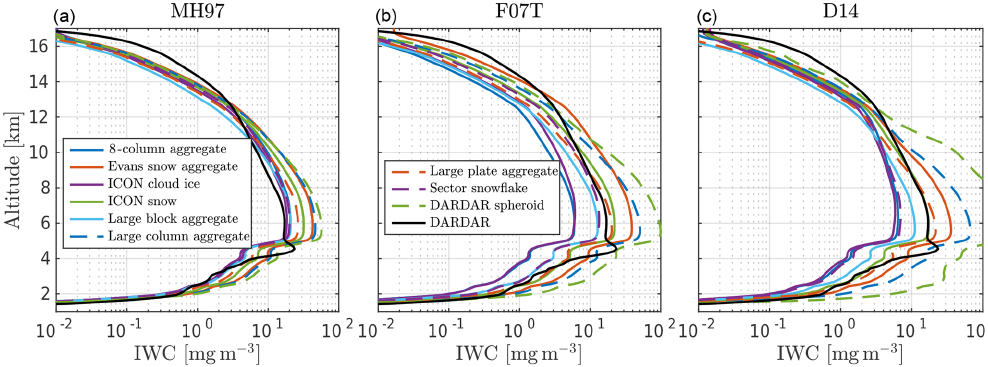
Figure 6. Mean IWC as a function of altitude. Assumed PSD is MH97 (a) , F07T (b) , and D14 (c) .